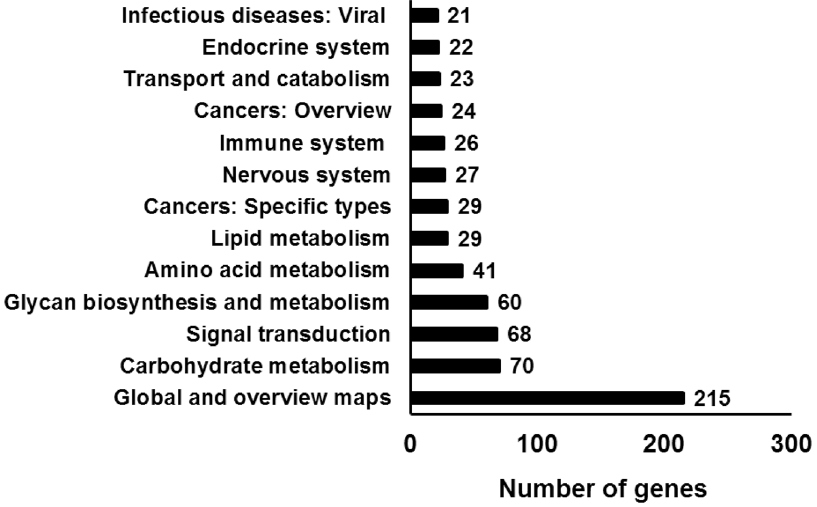
Figure 9. KEGG pathway analysis. The fungal mycelium was incubated with cAMP and IBMX. Transcriptome sequencing was performed to identify differentially expressed genes between the control and cAMP-treated mycelium. The differentially expressed genes were further mapped to the KEGG database. The major categories of differentially expressed genes are